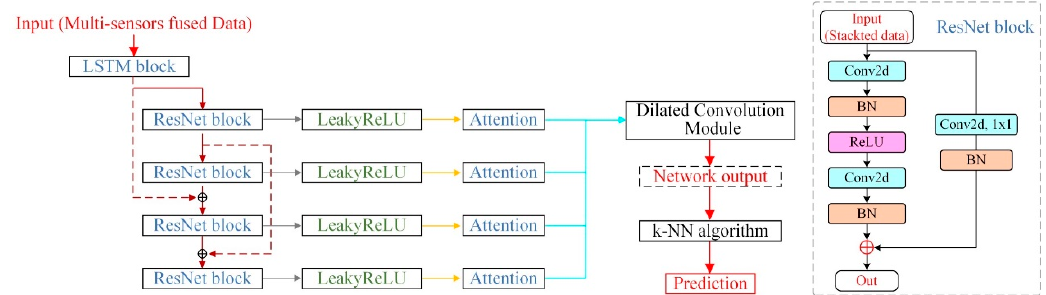
Figure 2. The network architecture of the proposed CNN-LSTM based on multi-sensor fusion. The basic LSTM block has three main